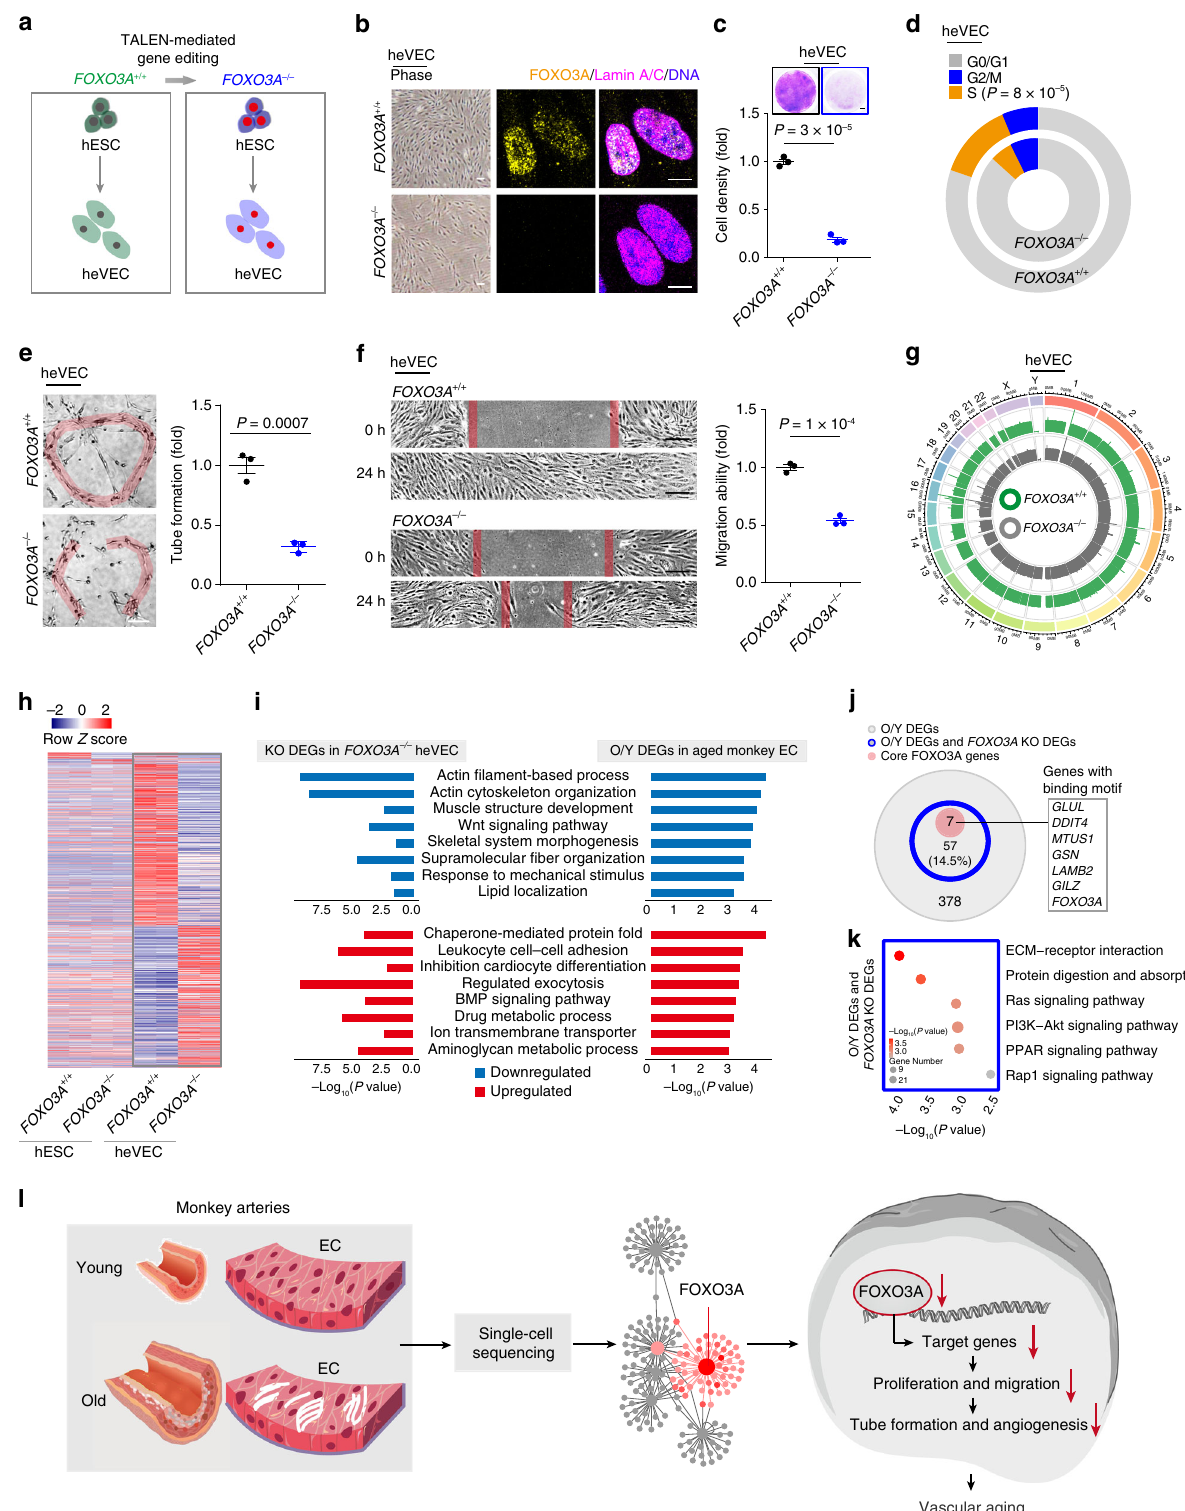
pathwayProtein digestion and pathwayRas signaling pathwayPI3K−Akt signaling